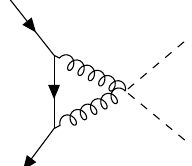
Figure 1. Sample diagram for q ¯ q → φφ and q ¯ q → ˜ φ ˜ φ at the LO. These vanish to all orders. The dotted lines either denote scalar Higgs or pseudo-scalar Higgs boson depending on the process under consideration.